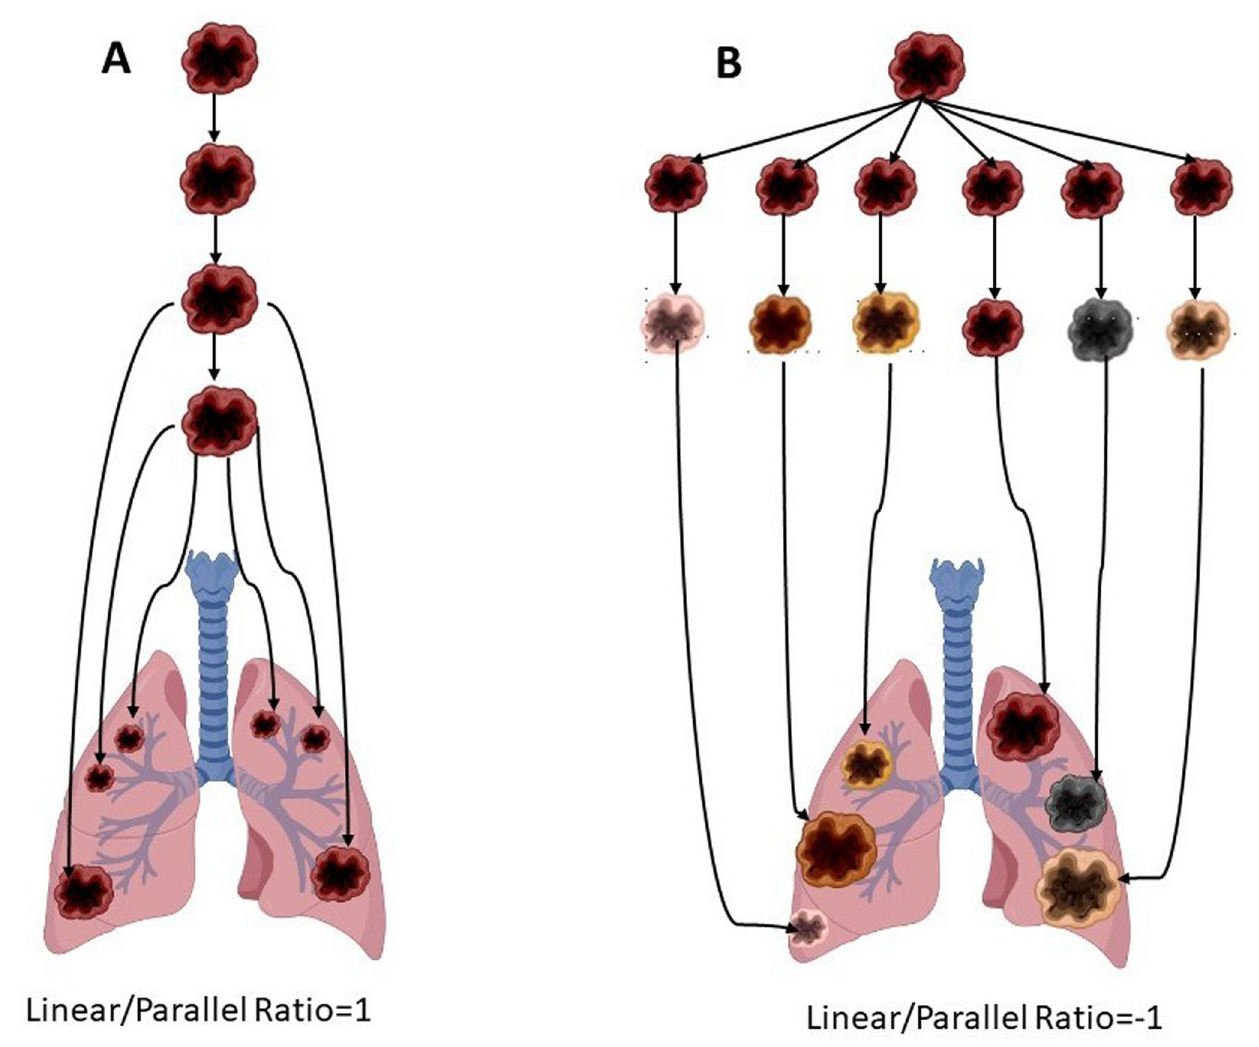
Fig 1. The linear and the parallel models of metastases